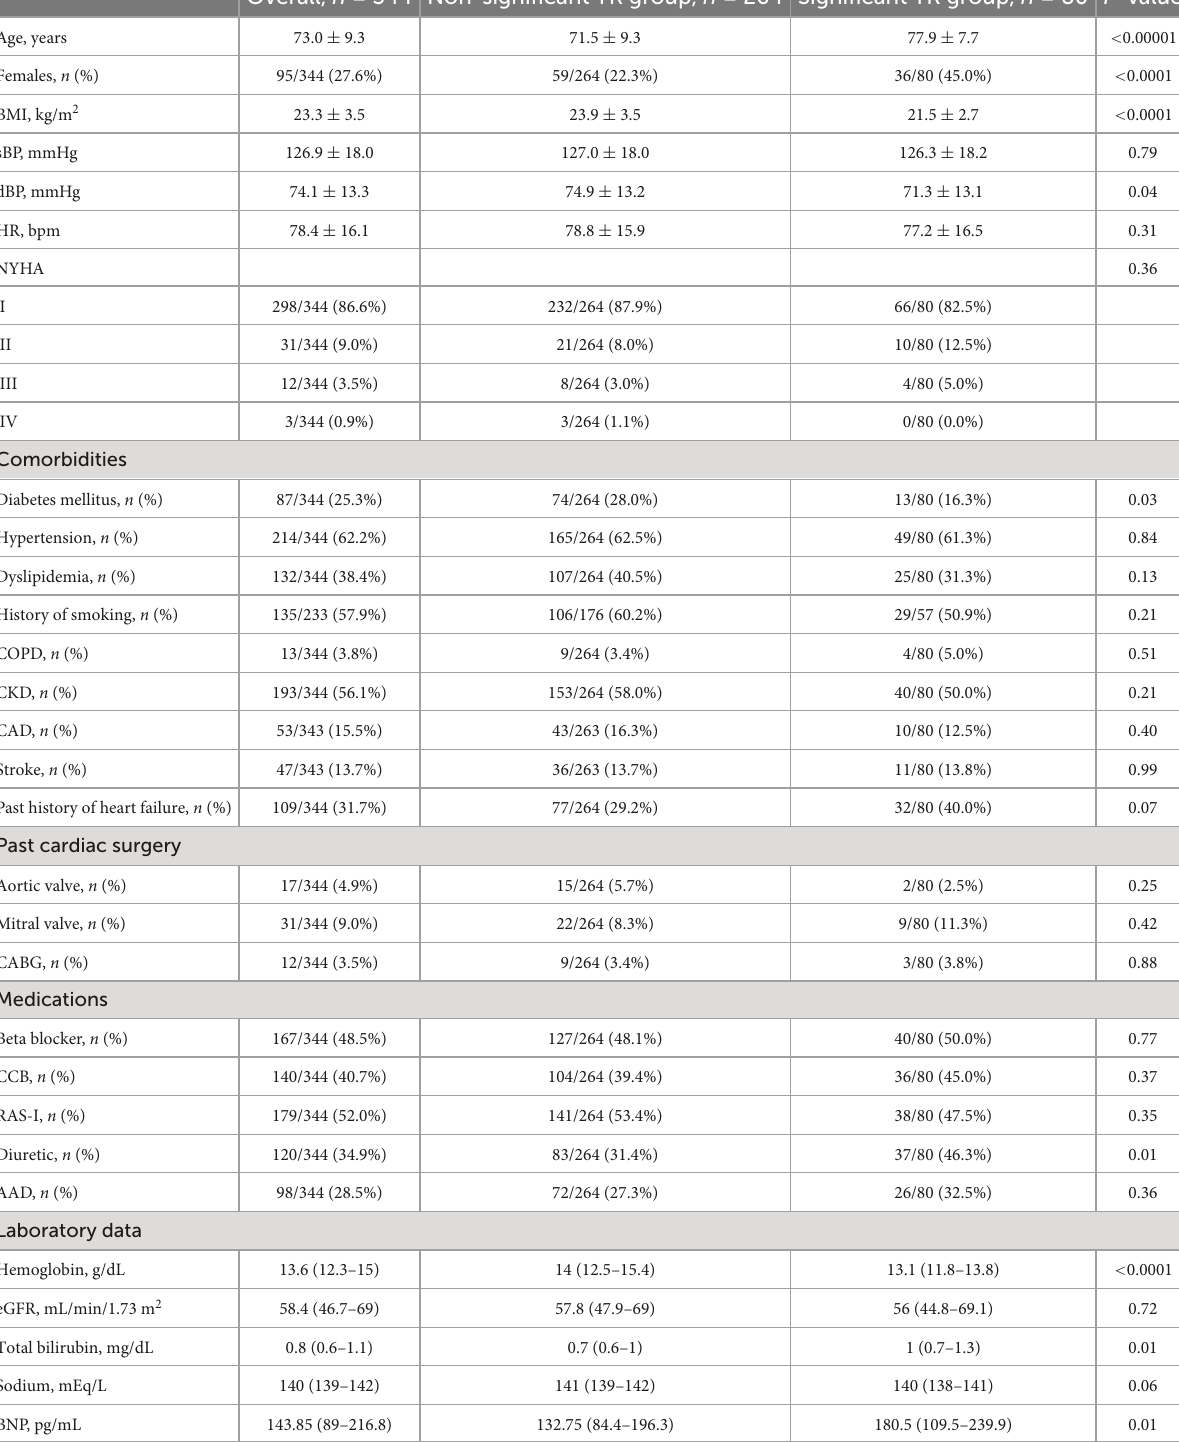
TABLE 1 Patient